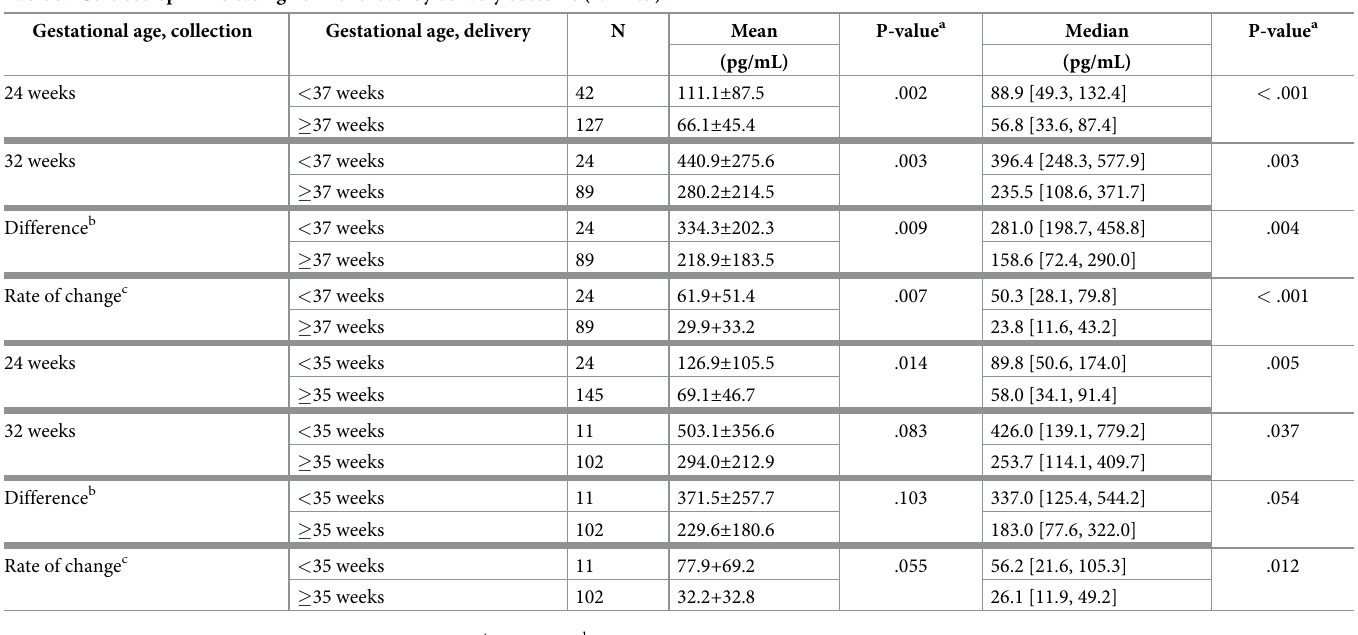
Table 3. Corticotrophin-releasing hormone level by delivery outcome (N =